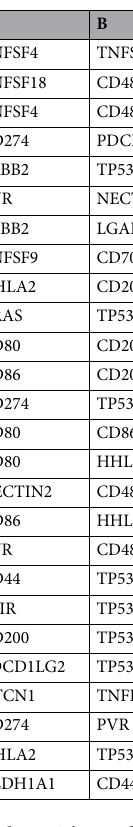
Table 1. The analysis tested in 276 pairs between the 24 tracks in the OncoPrint to reveal the connections among immunotherapies related genes. The close connections among the candidate immune checkpoints, and the connections among checkpoints and malignancy stimulators of either KRAS, TP53, ERBB2, ALDH1A1, CD44, were all calculated and exhibited. The close connections strongly suggested the crucial roles of candidate immune checkpoints in therapy response, and also suggested the potential effects they may